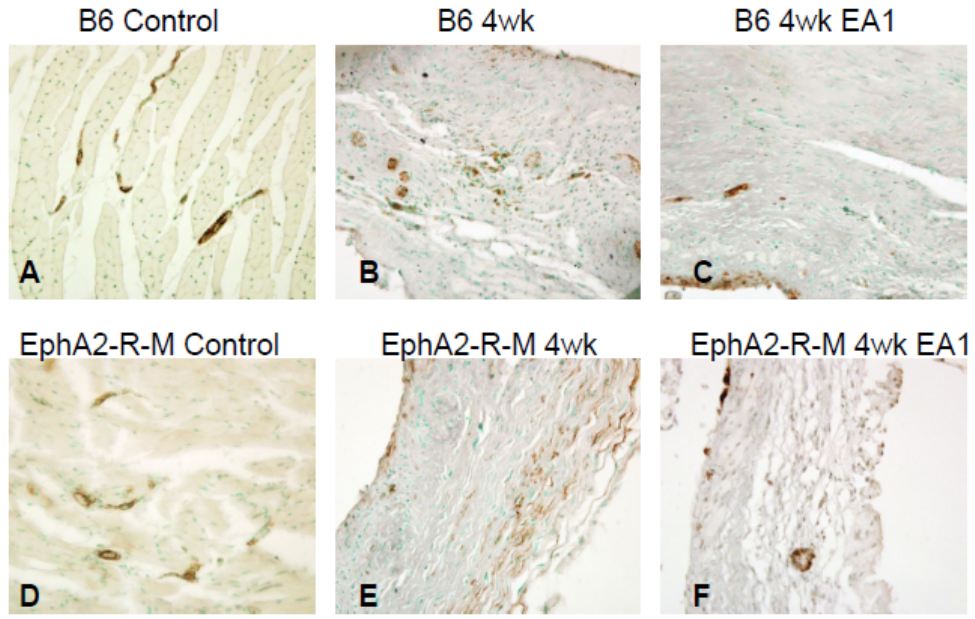
Figure 6. Active Myofibroblasts in Infarcted WT B6 ( A – C ) and EphA2-R-M ( D – F ) Mouse Hearts. Smooth muscle α -actin positive cells in uninjured B6 and EphA2 control heart tissue demonstrate expected staining of VSMCs in large vessels (200 × ). At 4 weeks post-MI, SM α -A positive myofibroblasts are visible in the infarcted myocardium in both B6 and EphA2, but to a much lesser extent in ephrinA1-Fc-treated B6 and EphA2-R-M mice ( n = 3/group).